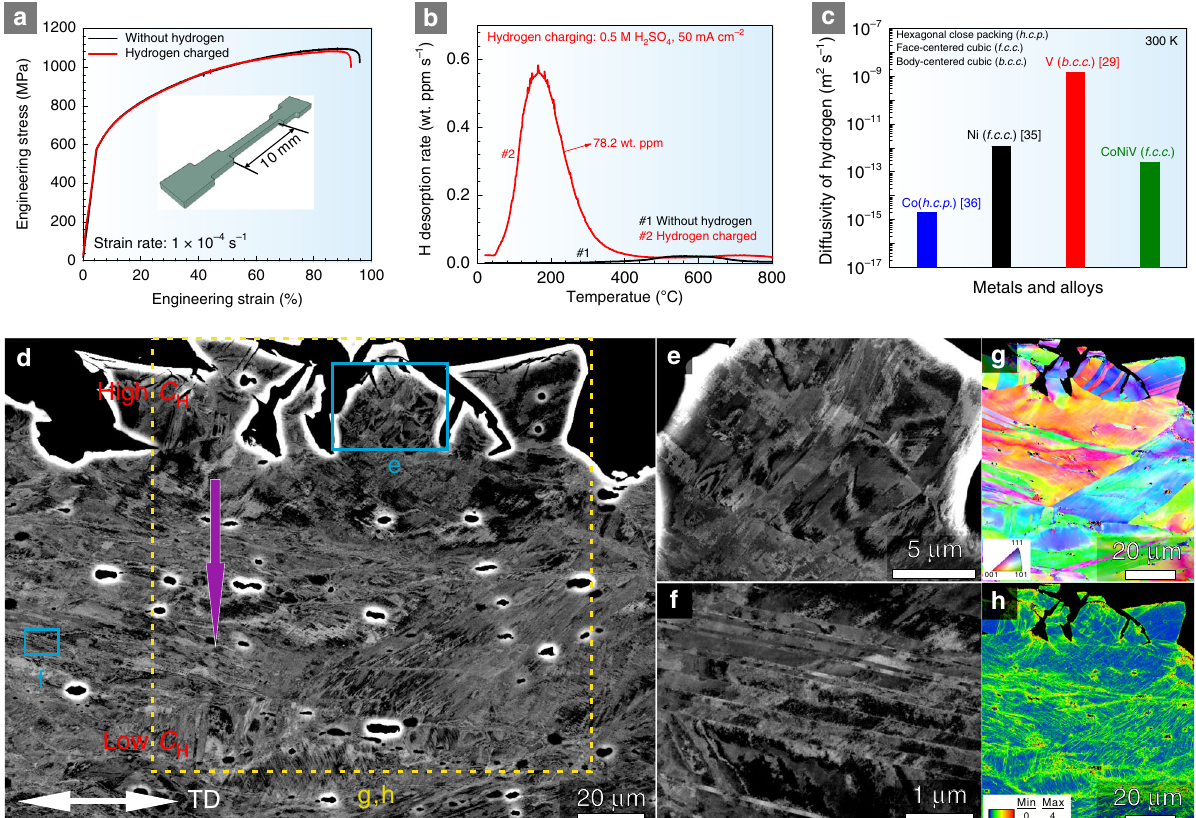
Fig. 2 Mechanical behavior and deformation microstructures near the fracture surfaces of equiatomic CoNiV MEA. a Mechanical behavior with/without in situ hydrogen charging, the samples were charged in 0.5 M H 2 SO 4 solution with 5 g L − 1 thiourea at a current density of 50 mA cm − 2 . The inserted fi gure shows the used tensile sample geometry. b Typical hydrogen desorption rate curve of the hydrogen-charged and tensile-tested samples. Prior to the in situ tensile testing, the samples were pre-charged for 24 h at 50 mA cm − 2 . c Hydrogen diffusivity of equiatomic CoNiV MEA at 300 K. The hydrogen diffusivity values of pure Ni 35 , Co 36 , and V 29 metals were selected as reference. d – h ECC images of deformation microstructures near the fracture surfaces of MEA samples charged with hydrogen. C H and TD refer to the hydrogen concentration and tensile direction,